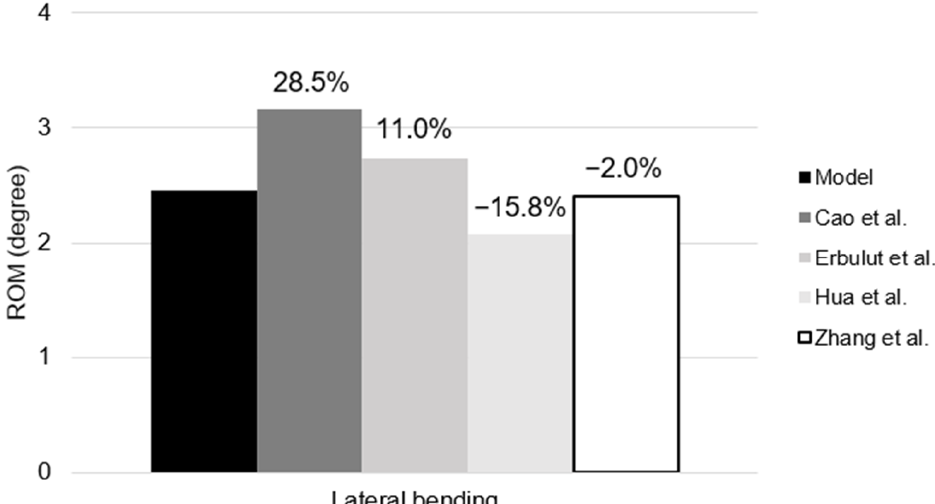
Figure 10. Lateral bending ROM of the FSU compared with previously validated FEM [14,32,33,40].